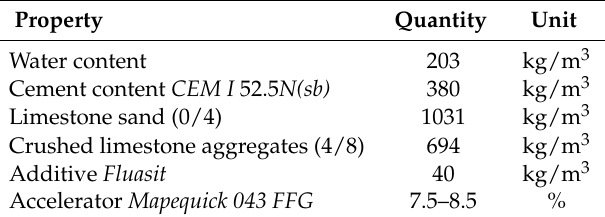
Table 1. Composition of the